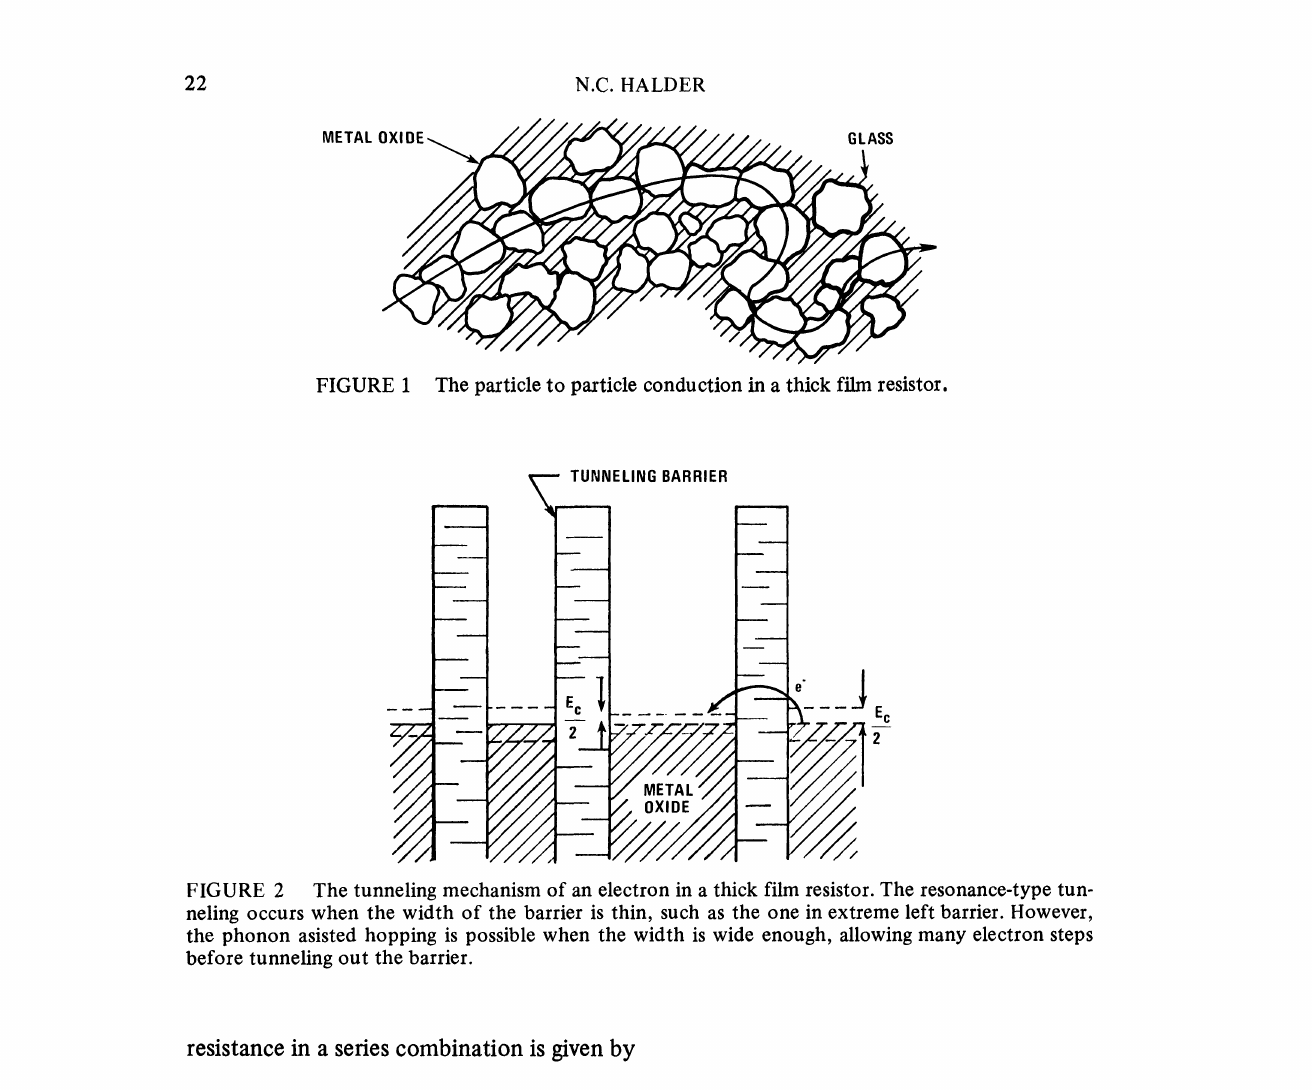
FIGURE The particle to particle conduction in a thick film resistor,